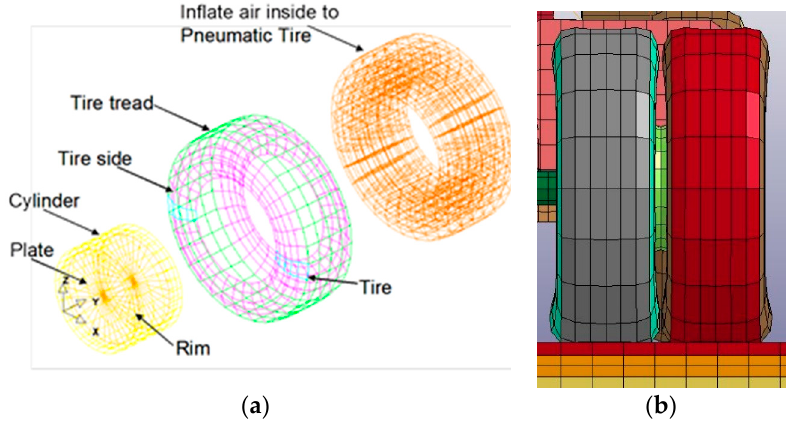
Figure 10. Pneumatic tire components adopted in ( a ) the vehicle model and ( b ) the tire model front section during a general time step.